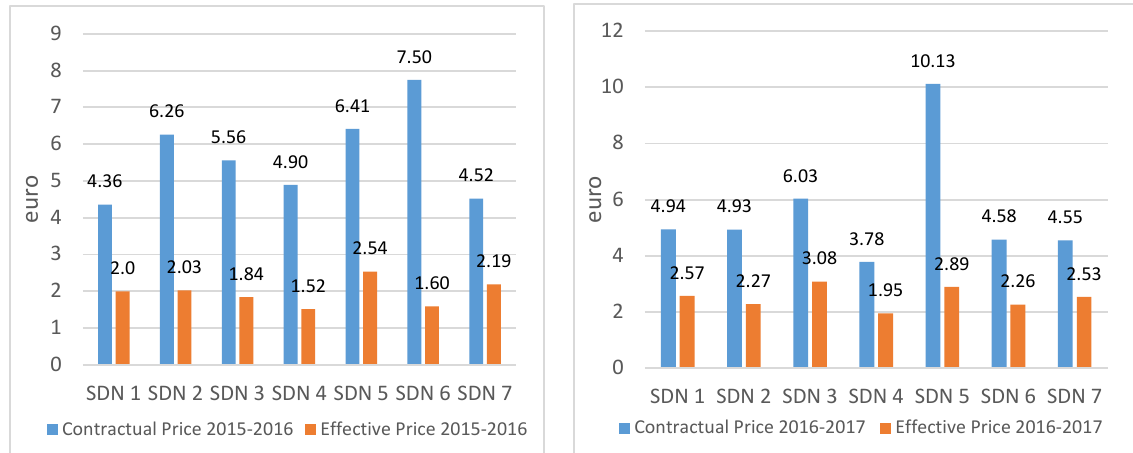
Figure 1. Comparison between contractual price and effective price per kilometer, in euro, during 2015–2016 and 2016–2017. Source: own processing using Statistical Package for the Social Sciences (SPSS) 23 software.